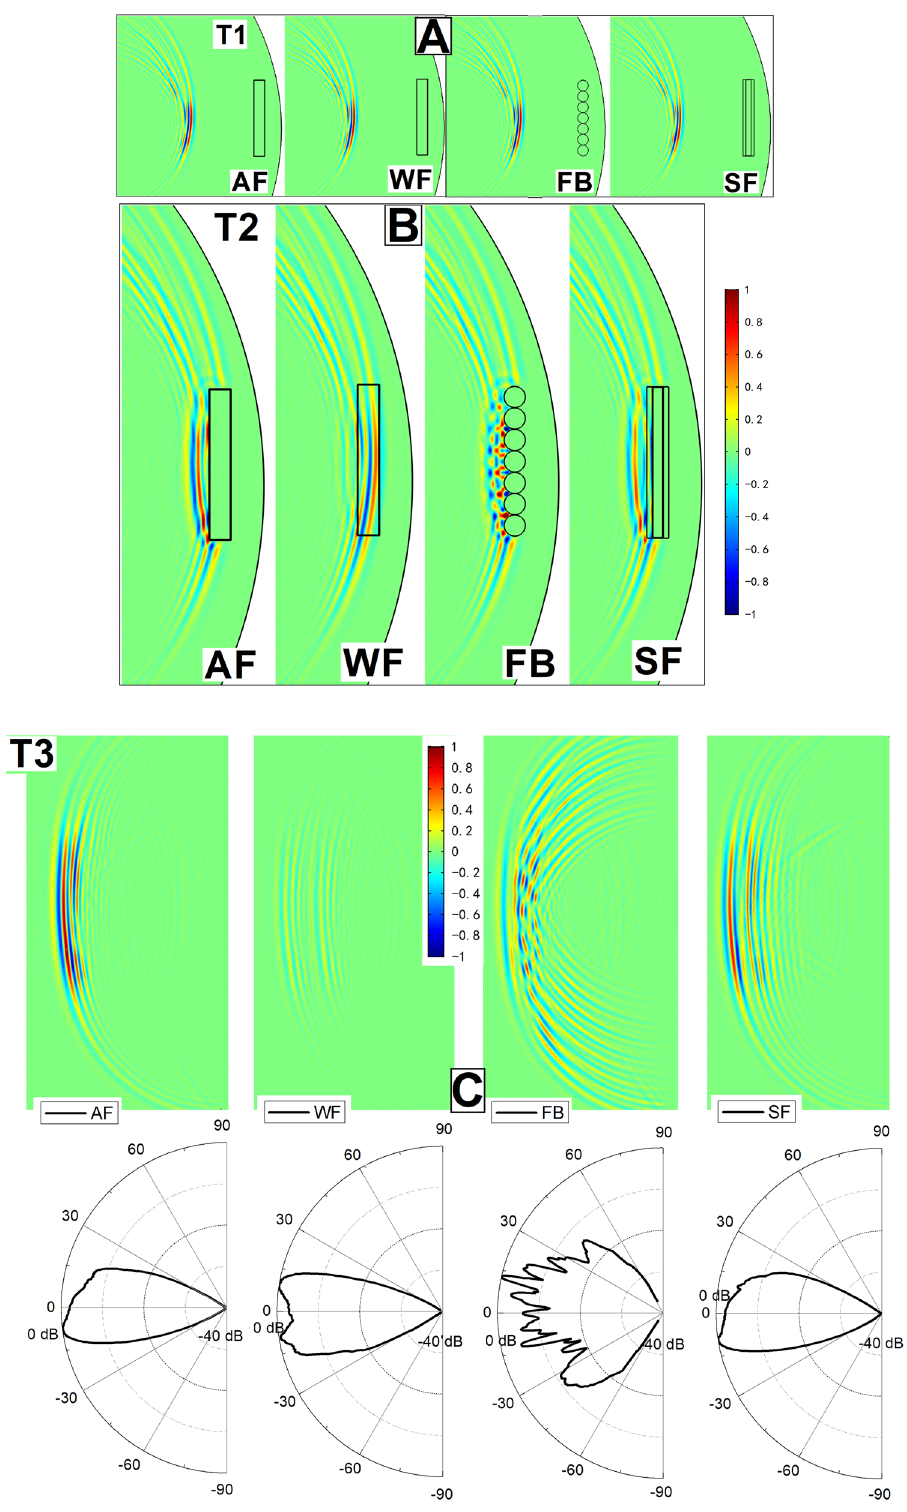
Figure 2. The time history of the click wavefront interacting with the object in each case. Colour bars display the relative sound pressure values which were normalized according to the maximum sound pressure value of the AF case. ( A ) T1 shows the instant where the clicks were travelling through seawater before interacting with the objects. ( B ) T2 shows the instant when the clicks were reflected and refracted by the four objects. ( C ) T3 shows the instant when the echoes were formed by the objects, transmitting back to the dolphin at a distance of 0.5 m from the dolphin’s sound source in the four cases. The corresponding beam pattern of the echo in each case is plotted in the bottom panel. The detailed acoustic processes from T2 to T3 for each case are provided in Supplementary Video